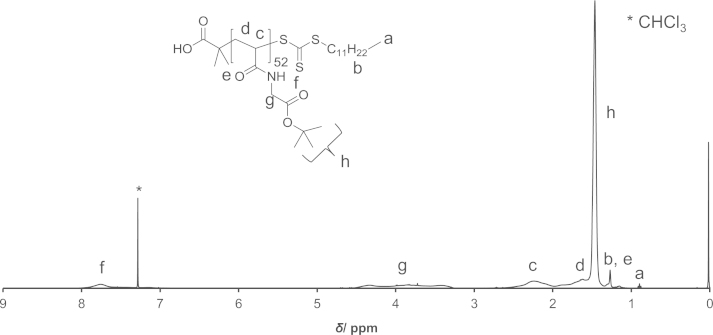
1H NMR spectrum of PAG polymer (3).